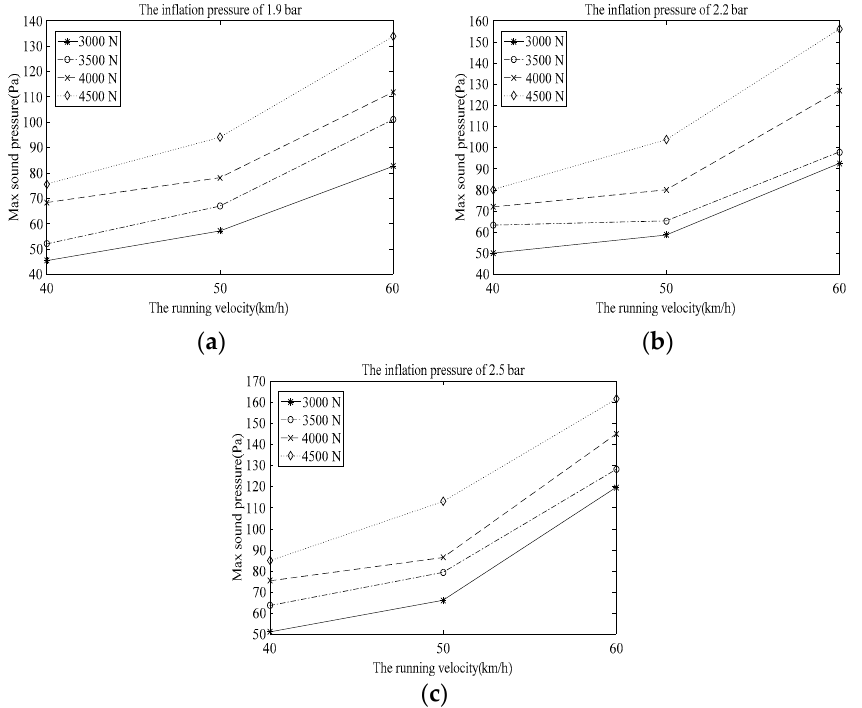
Figure 16. Variation of maximum acoustic pressure amplitudes with running speeds: ( a ) For the inflation pressure of 1.9 bar; ( b ) For the inflation pressure of 2.2 bar; ( c ) For the inflation pressure of 2.5 bar.